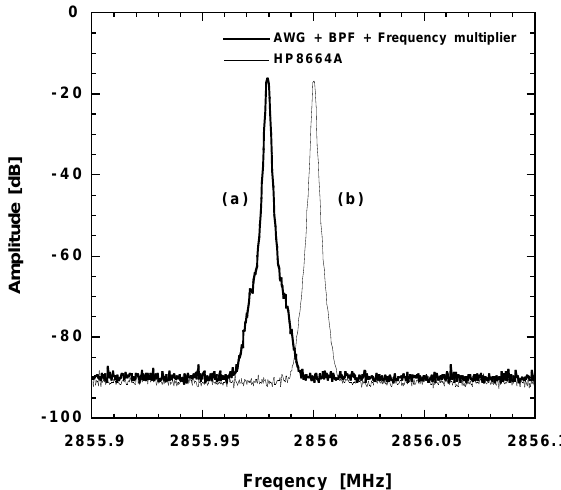
FIG. 2. Obtained spectra of 2856 MHz rf’s: (a) generated by the new method and (b) generated by a